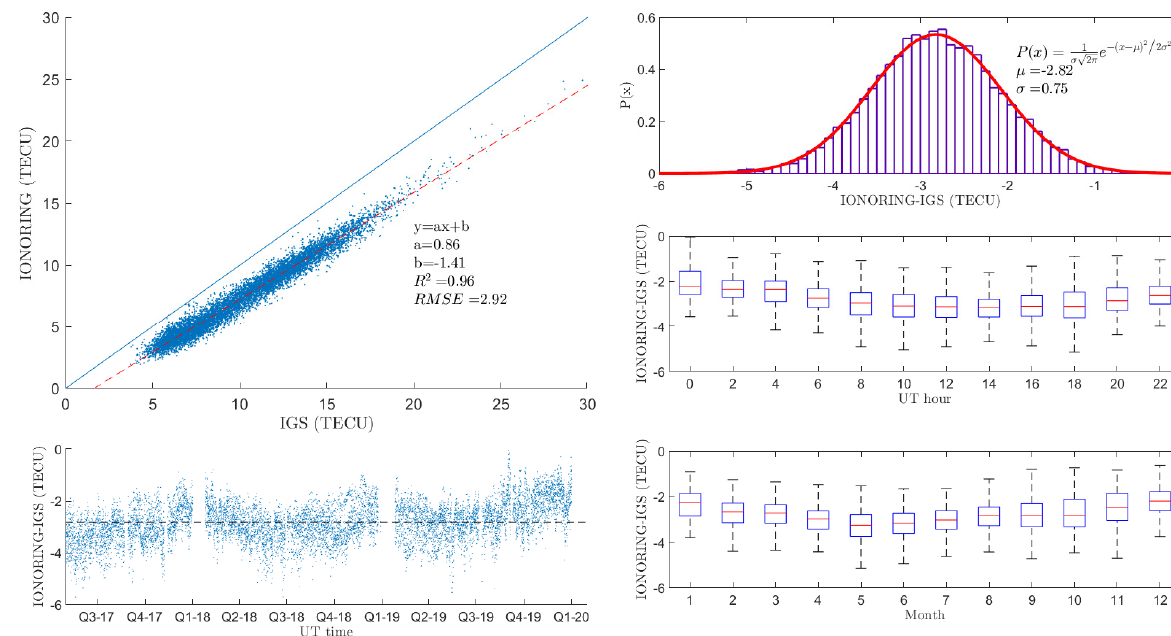
Figure 3. The same as Figure 2 but referring to the IONORING validation against the vTEC maps provided by the Royal Observatory of Belgium (ROB). The linear fit (red-dashed line) and its features (in the textbox) are reported, while the blue line indicates the bisector (panel a ). Time profile of the difference between IONORING and ROB vTEC (panel b ). Proba- bility distribution of the difference between IONORING and ROB vTEC and the corresponding Gaussian fit (red), whose expression and parameters are also reported in the textbox (panel c ). Boxplots of the hourly (panel d ) and monthly (panel e ) differences between IONORING and ROB vTEC. In the boxplots, the red line indicates the median, and the bottom and top edges of the box indicate the 25 th and 75 th percentiles, respectively, while the range marked by the dashed lines indi- cates the extrema.